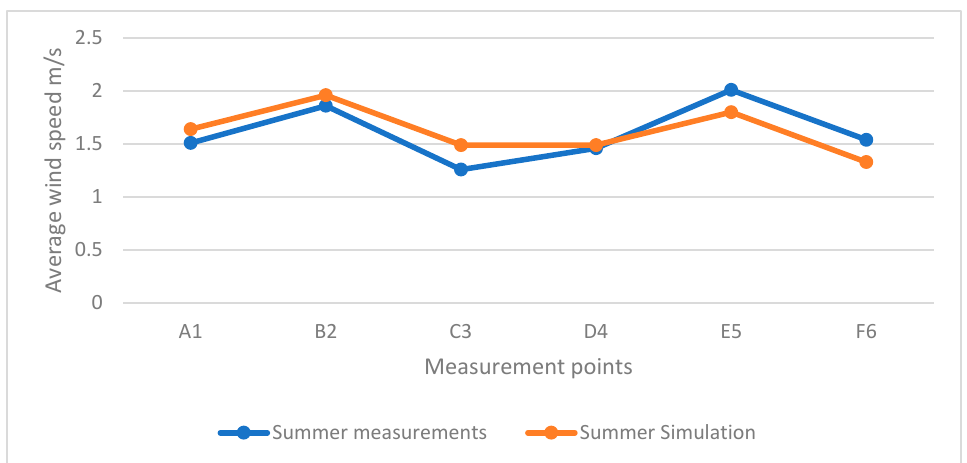
Figure 5. ( a ) Simulation of the summer wind environment in Zhuqiao village; ( b ) Simulation of the summer thermal environment in Zhuqiao village.